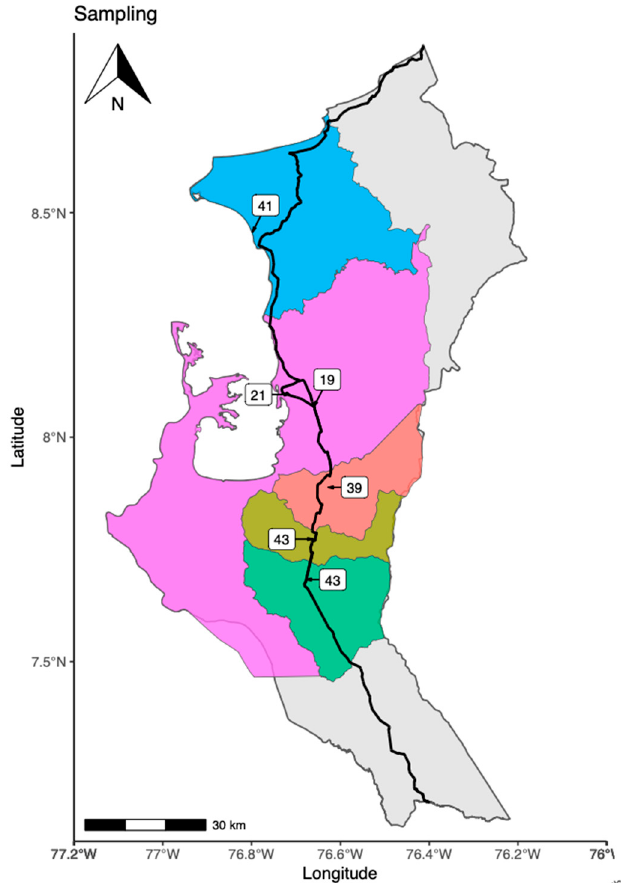
Figure 1. The geographical location of capture sites. The map shows the geographical location of the five municipalities that were used to capture the 206 bats used in this study (blue ‐ Necoclí, purple ‐ Turbo, orange ‐ Apartadó, dark green ‐ Carepa and light green ‐ Chigorodó). These capture sites are located in the Urabá region (Antioquia ‐ Colombia). The map was generated using the environment and programming language R and packages (ggplot2, MappingGIS, sfMaps, spData, ggrepel, ggspatial, cowplot).